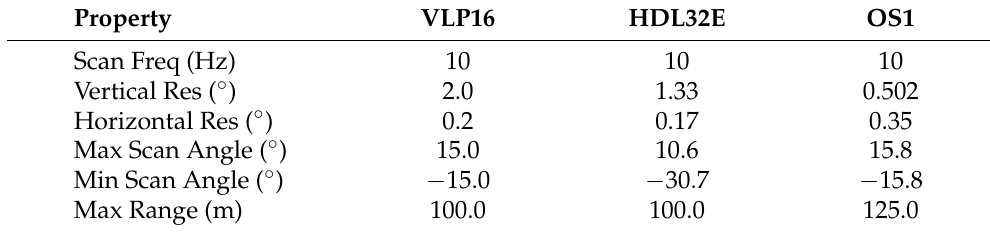
Table 3. Values for the sensors used in the experiments. All sensors UAV-mounted unless other- wise